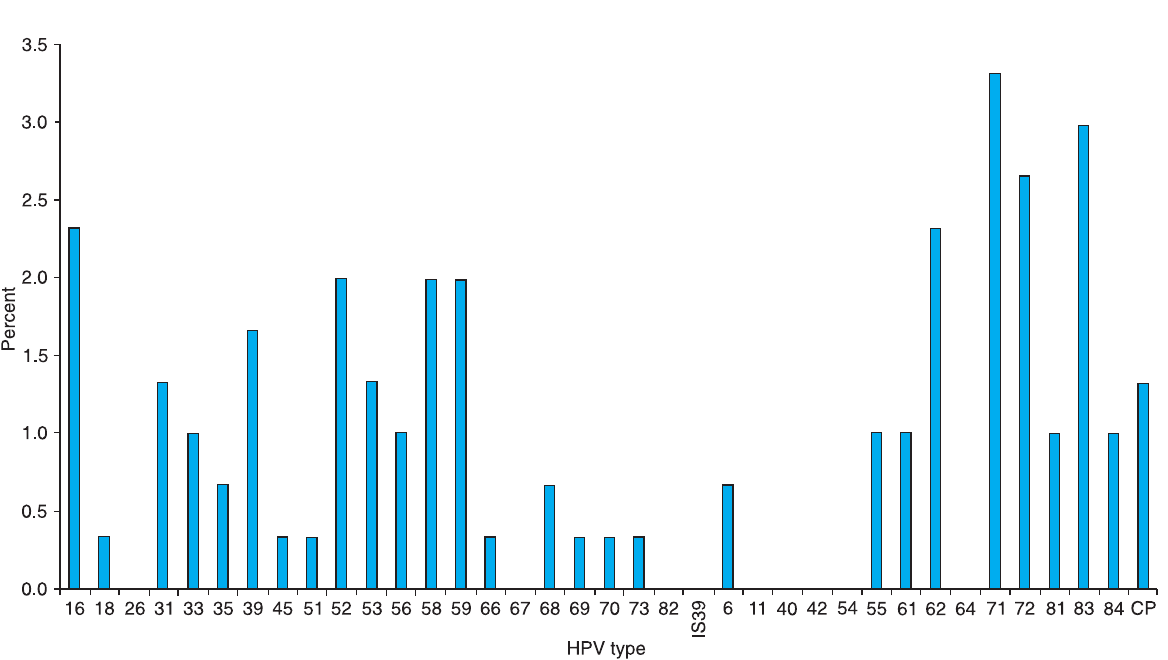
Figure 1. Detection of specific human papillomavirus (HPV) types in 302 participants. The percent of each HPV type detected is indicated on the y-axis and the specific HPV types that have been detected are indicated on the x-axis. A woman was considered to be infected with an HPV type if either the cervical or vaginal swab contained that HPV